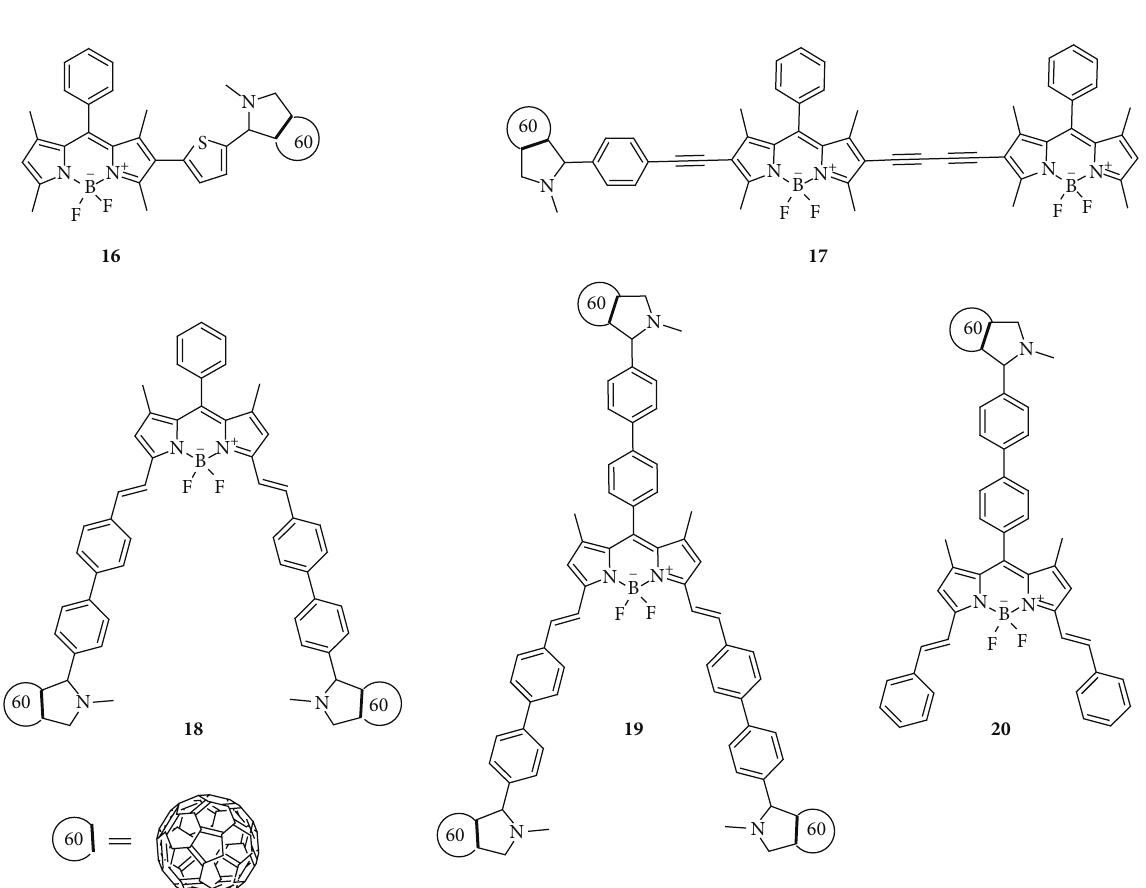
Figure 8: PET modulated singlet to triplet conversion.